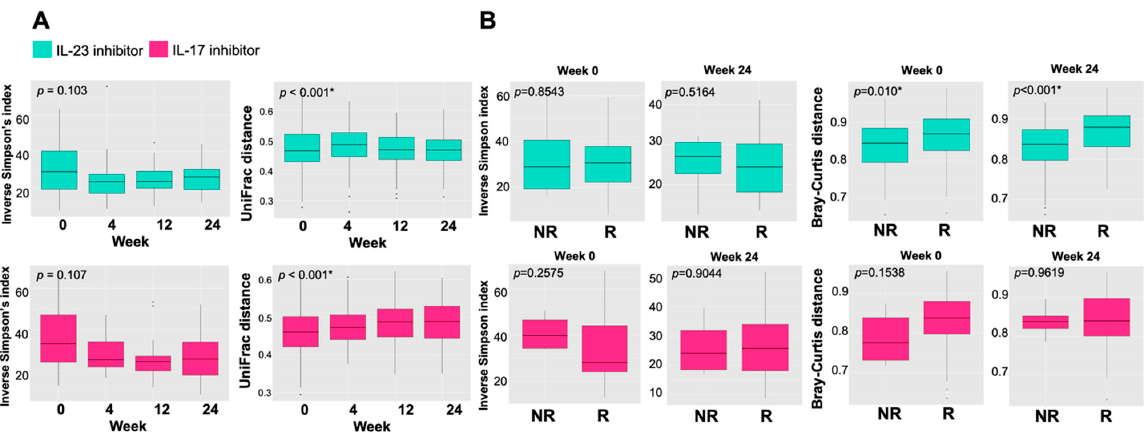
Figure 2. Gut microbial composition in psoriatic patients during the 24 weeks of treatment with IL-23 (guselkumab) or IL-17 (secukinumab and ixekizumab) inhibitors. ( A ) The distribution of α -diversity (Inverse Simpson’s index) and β -diversity (UniFrac distance) of gut microbiota at weeks 0, 4, 12, and 24 in patients treated with IL-23 or IL-17 inhibitors. ( B ) The distribution of α -diversity (Inverse Simpson’s index) and β -diversity (Bray–Curtis distance) at weeks 0 and 24 between responders (R) and non-responders (NR) of the two groups. * p < 0.05.